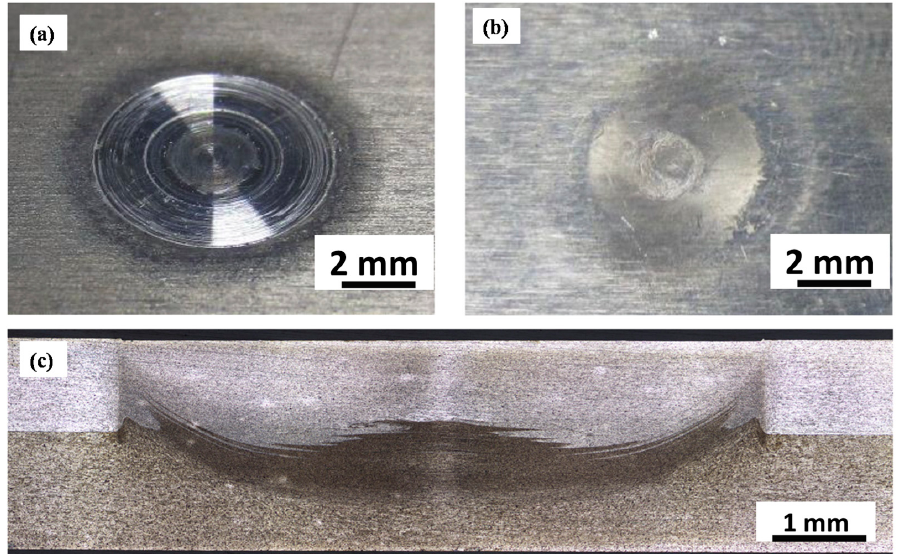
Figure 10 . RFSSW joint between AA2024-T3 and AA7075-T6 sheets for aerospace applications. ( a ) Top view, ( b ) bottom view and ( c ) transverse cross-section macrograph [47] (has permission from Elsevier).